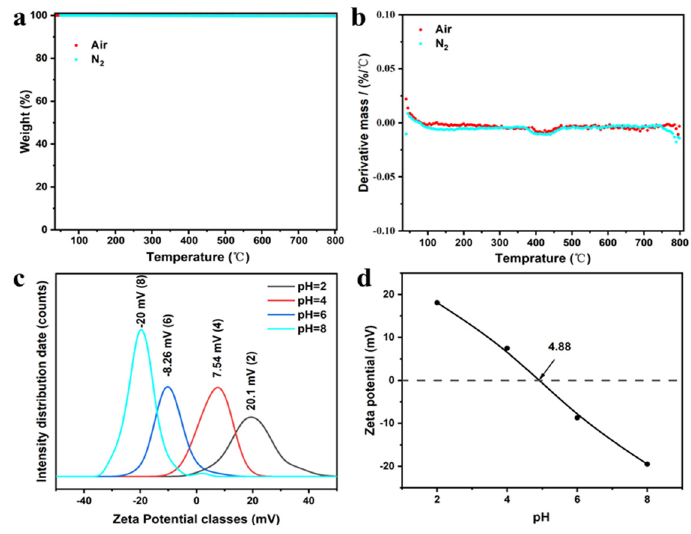
Figure 6. ( a ) TGA; ( b ) DTG; ( c ) Zeta potential of various pH with 2, 4, 6, and 8; ( d ) The variation curve for zeta potential as a function of pH value of CMO-8.